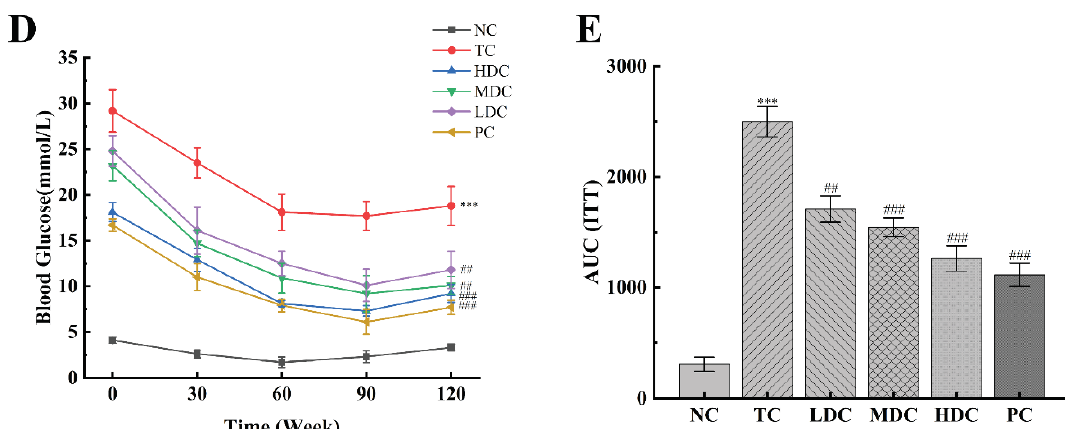
Figure 4. Effect of PSS on insulin sensitivity in mice. ( A ) The serum insulin content. ( B ) The HOMA- IR scores. ( C ) The HOMA-β scores. ( D ) Insulin tolerance test (ITT) experiment results. ( E ) The area under the curve (AUC) of ITT. Data are presented as mean ± SD (n = 8); *** p < 0.001 compared to the NC group; ## p < 0.01 and ### p < 0.001 compared to the TC group.